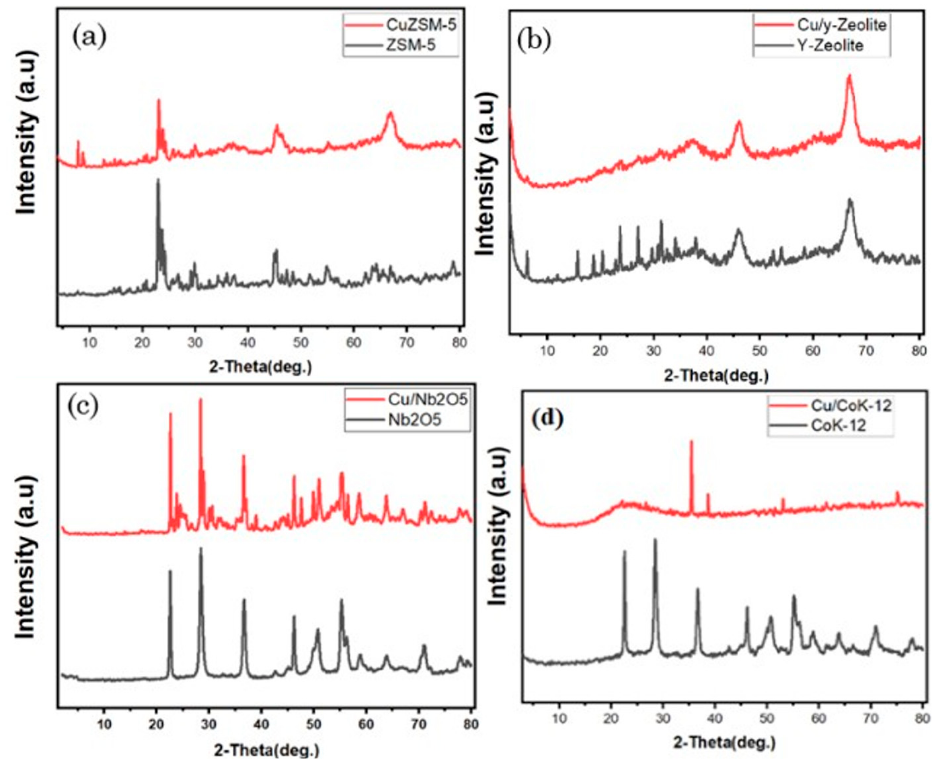
Figure 2. XRD pattern of ( a ) Cu-ZSM5 and ZSM5, ( b ) Cu-Y-Zeolite and Y-Zeolite, ( c ) Cu-Nb2O5 and Nb2O5, ( d ) Cu-COK12 and COK12.